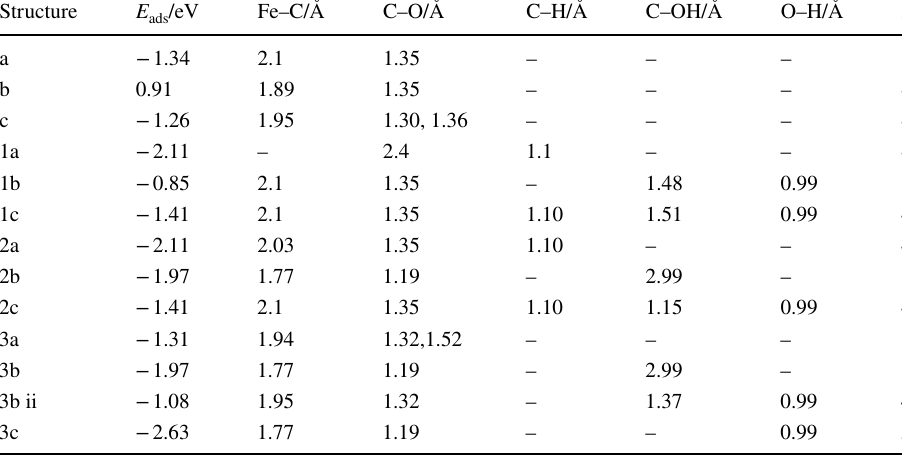
of activated and hydrogenated carbon dioxide molecule, ƞ is the coordination number i.e., the number of surface Fe atoms linked to CO